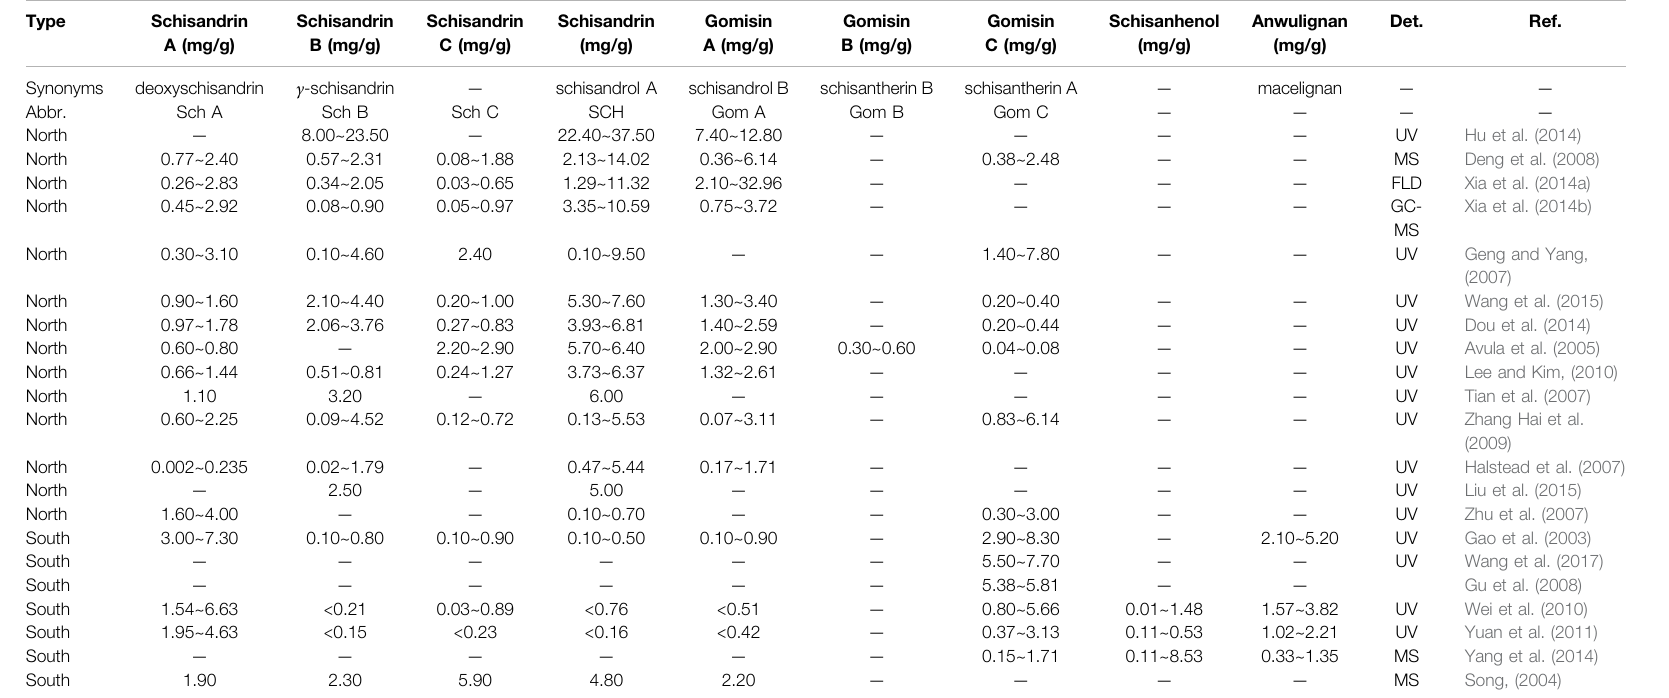
TABLE 1 | Contents of major schisandra lignans of Wu Wei Zi.